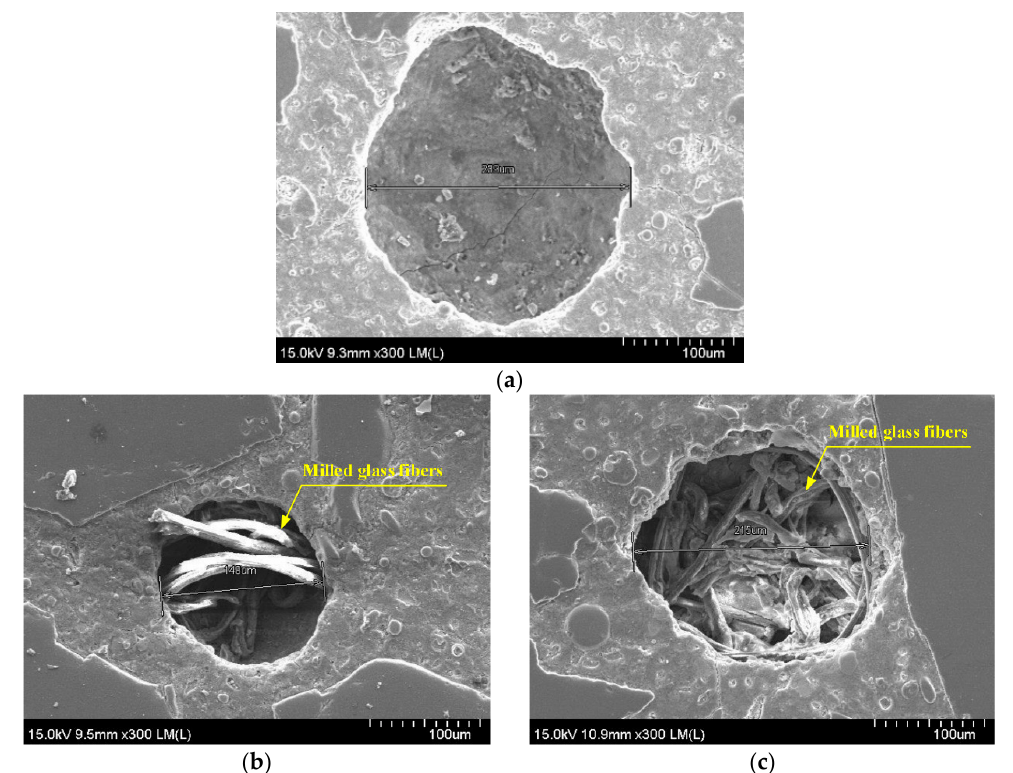
Figure 10. Pores in a mortar mixture containing MGFs: ( a ) M0.00, ( b ) M0.05, and ( c ) M0.10. Table 7. Pore sizes and widths of the interfacial transition zone (ITZ).